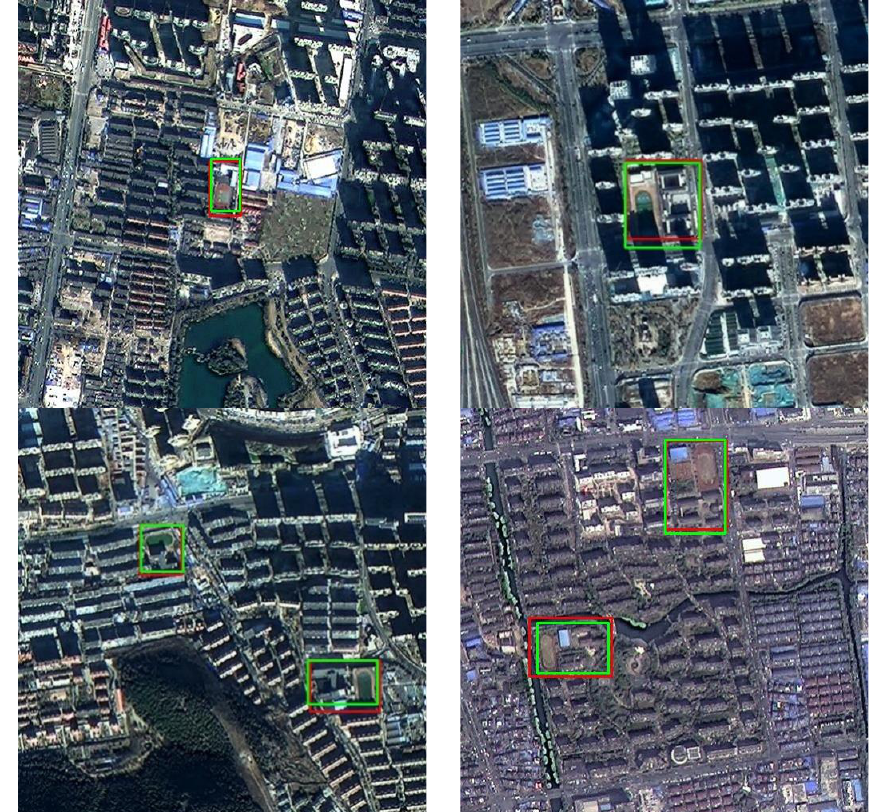
Figure 9. Visualization of the detection results of Huadong region. The ground truth boxes are plotted in green and the detection results of the proposed method are plotted in red .